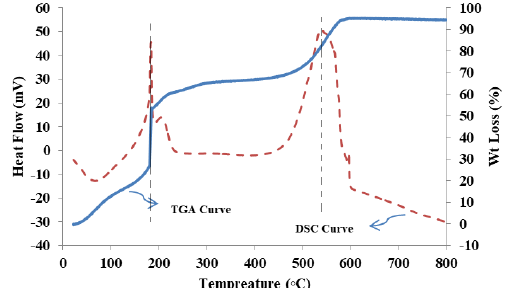
Fig. 2 FTIR spectra of GO and GO-NiHCF samples Fig. 3 TGA and DSC curves of GO-Nickel hexacyanoferrate